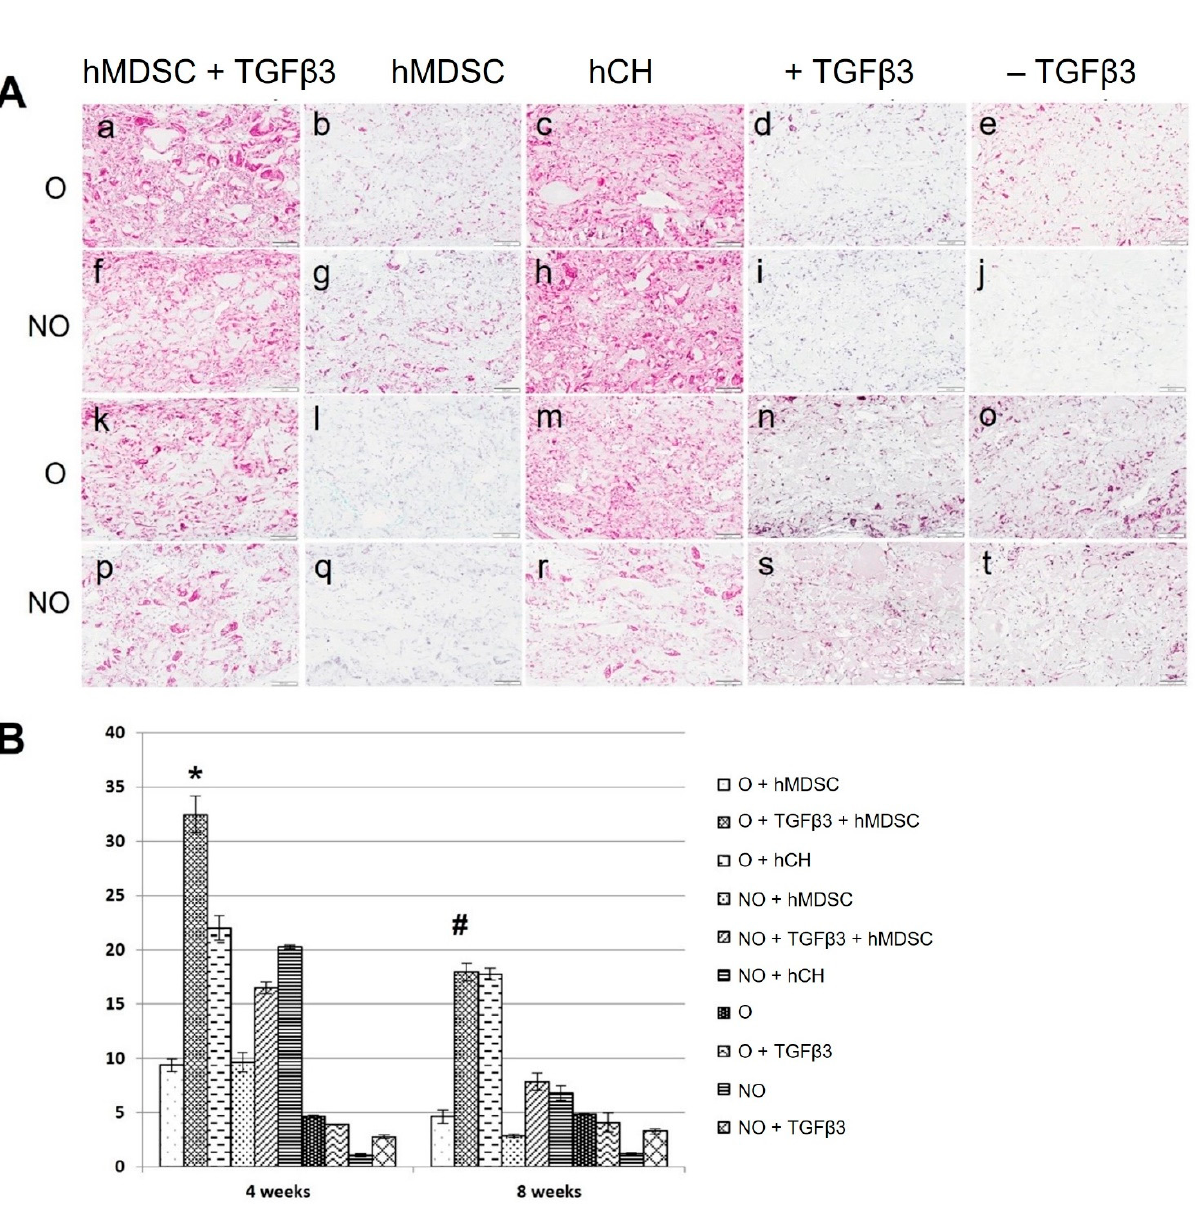
Figure 6. GAG formation in O and NO scaffolds in vivo after 4 weeks (a–j) and 8 weeks (k–t) ( A ), and quantification of Safranin O staining ( B ). Cell-free scaffolds (d,e,I,j,n,o,s,t). NO—untreated, O—ozone-treated, hMDSC—human-muscle-derived stem cells, hCH—human chondrocytes, TGF β 3—transforming growth factor beta-3. Results are presented as mean +/ − standard deviation. The * represents p -value < 0.05 compared to all other treatment groups after 4 weeks. The # represents p -value < 0.05 compared to all other treatment groups except the O + hCH group at 8 weeks. Scale bar—100 μ m.